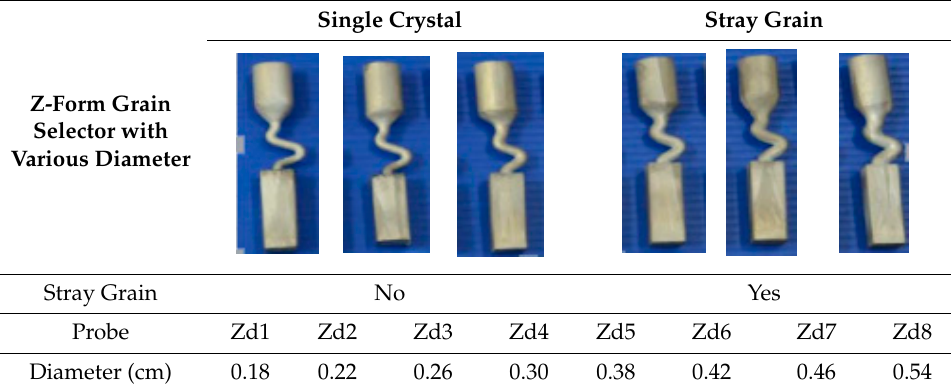
Table 1. Variation in thickness of the grain selector portion.